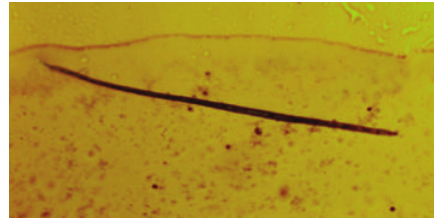
Figure 3: Microfilaria of Dirofilaria repens ( × 200).